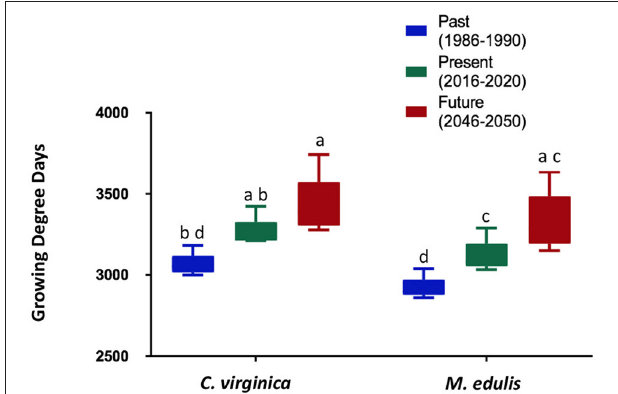
FIGURE 3 | Growing-degree days for C. virginica and M. edulis for each time period analyzed. Upper thermal tolerances were 35 and 23 ◦ C, and lower thermal tolerances were 2 and − 1.8 ◦ C, respectively. This was done for the warmest coastal pixel within the area analyzed. Bars not sharing the same letters indicate significantly different groups ( p <